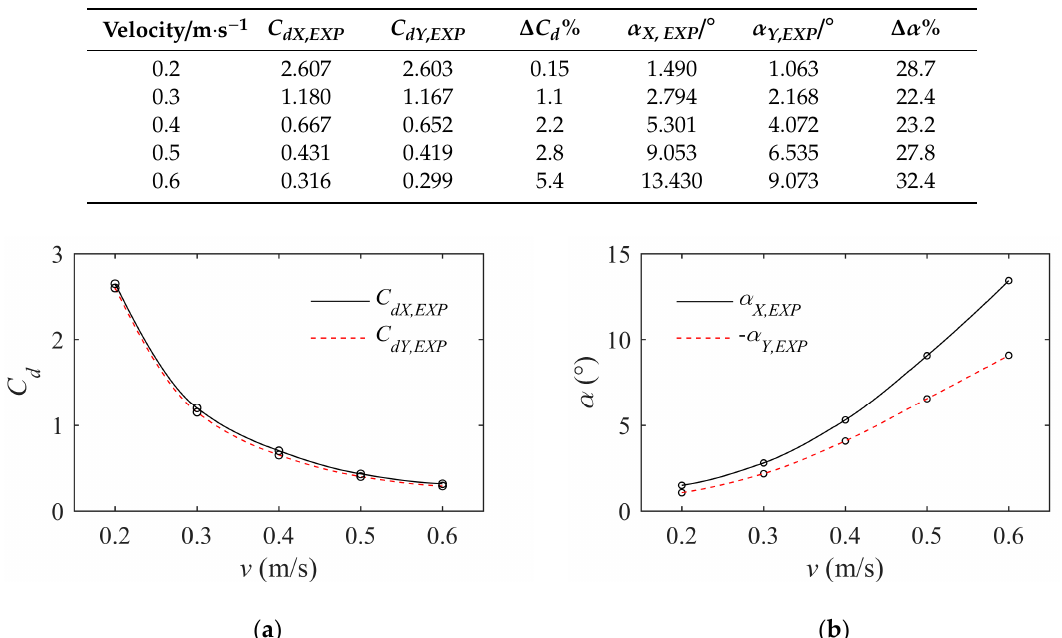
Table 2. Variation in drag coe ffi cient and o ff set angle with velocity.